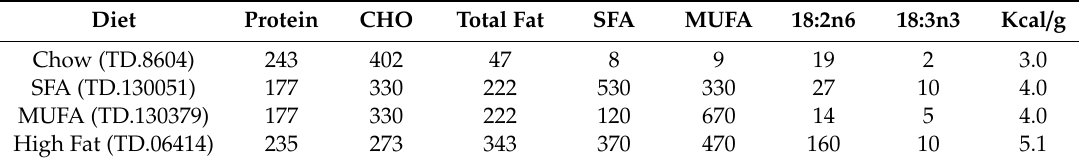
Table 2. Composition of fat-enriched diets.